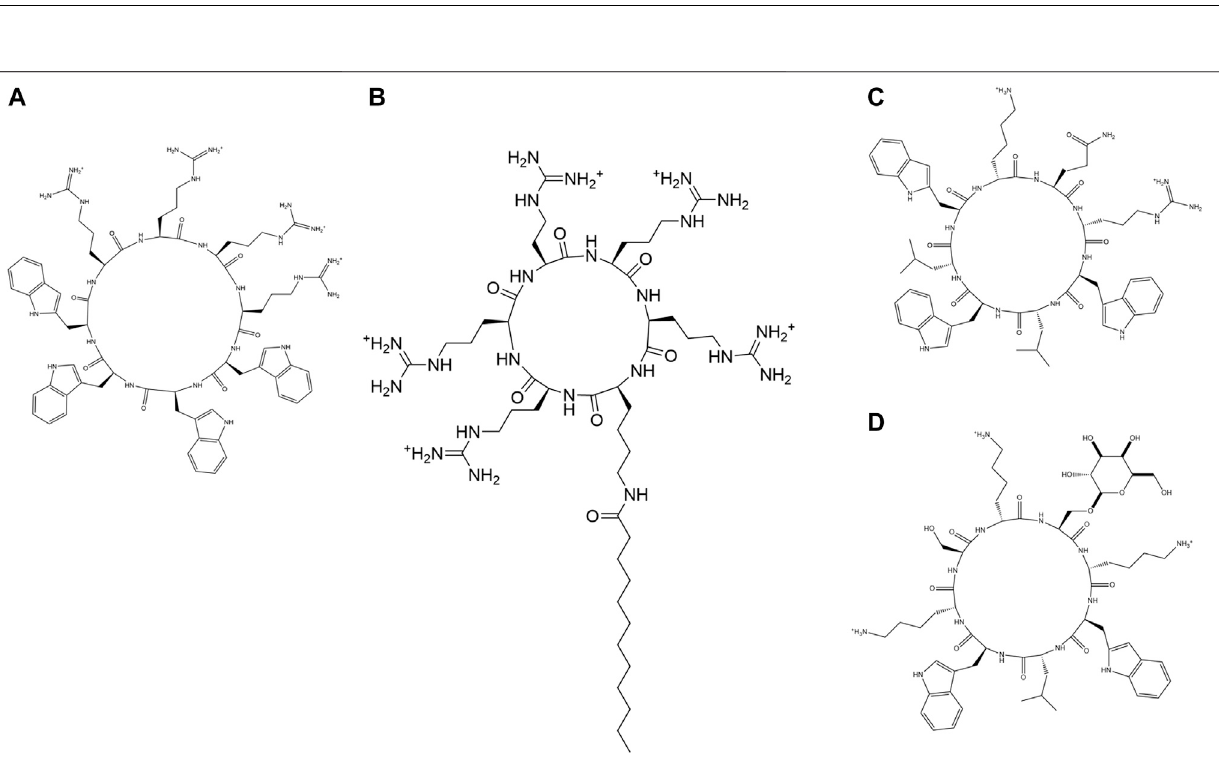
Synthetic cyclic peptide (Gly) 6 ccTP, an analog of the β -stranded AMP tachyplesin, showed salt tolerant activity against several microbial strains. (Gly)6ccTP contained eight mutated